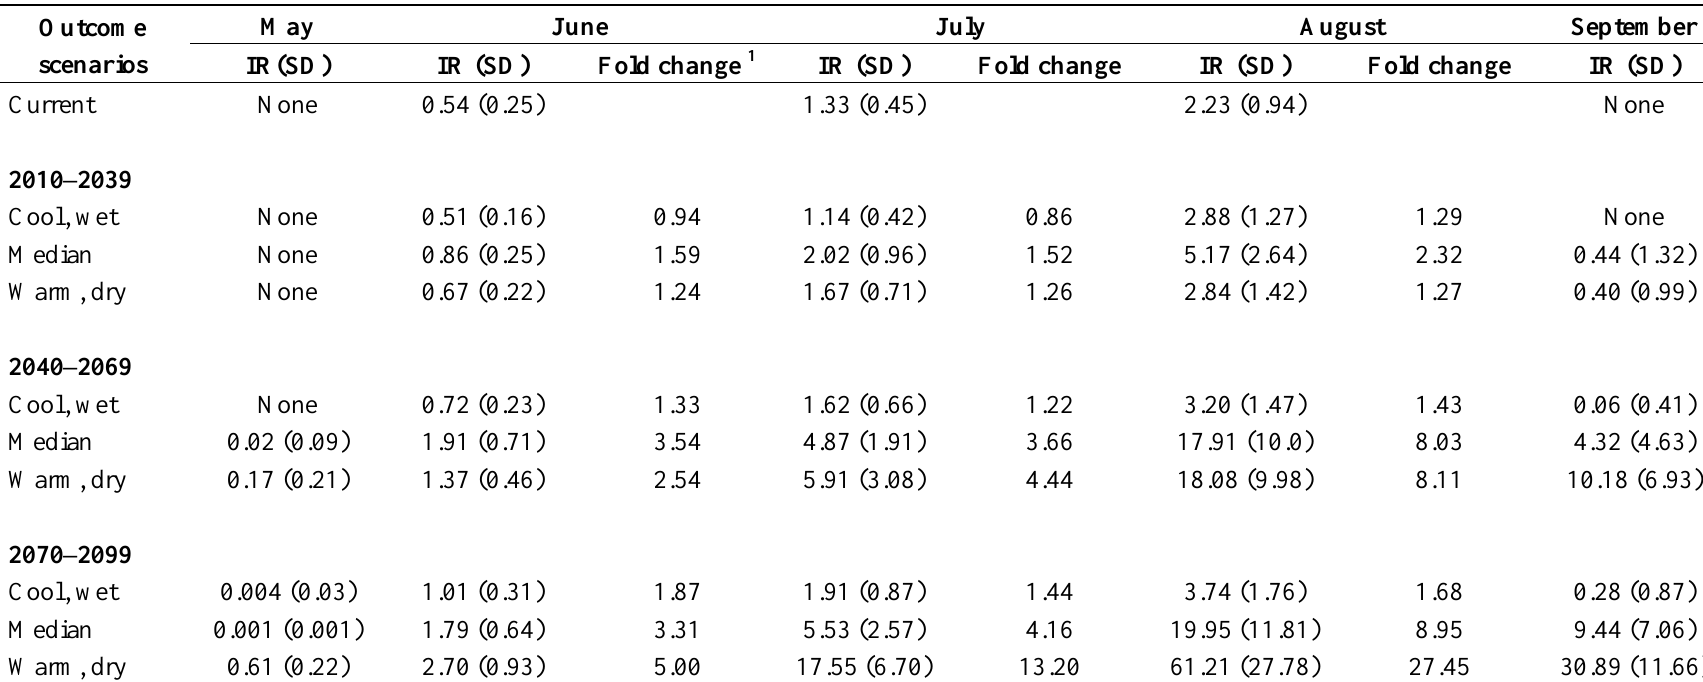
Table 6. Temporal distribution and fold change of WNV infection rate (number of infected mosquitos per 1,000 mosquitoes) in Cx. tarsalis mosquitoes in the Canadian prairie ecozone for current and three future periods of selected outcome